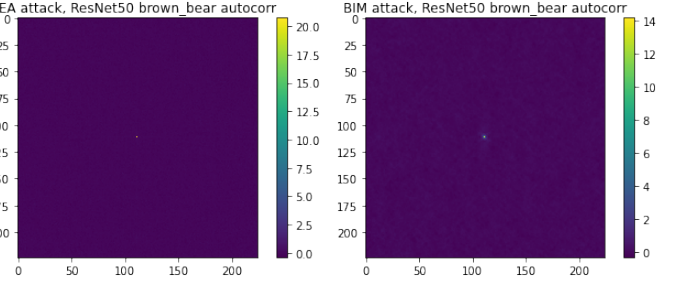
( A 4 ) − A 4 for the 5 5 6